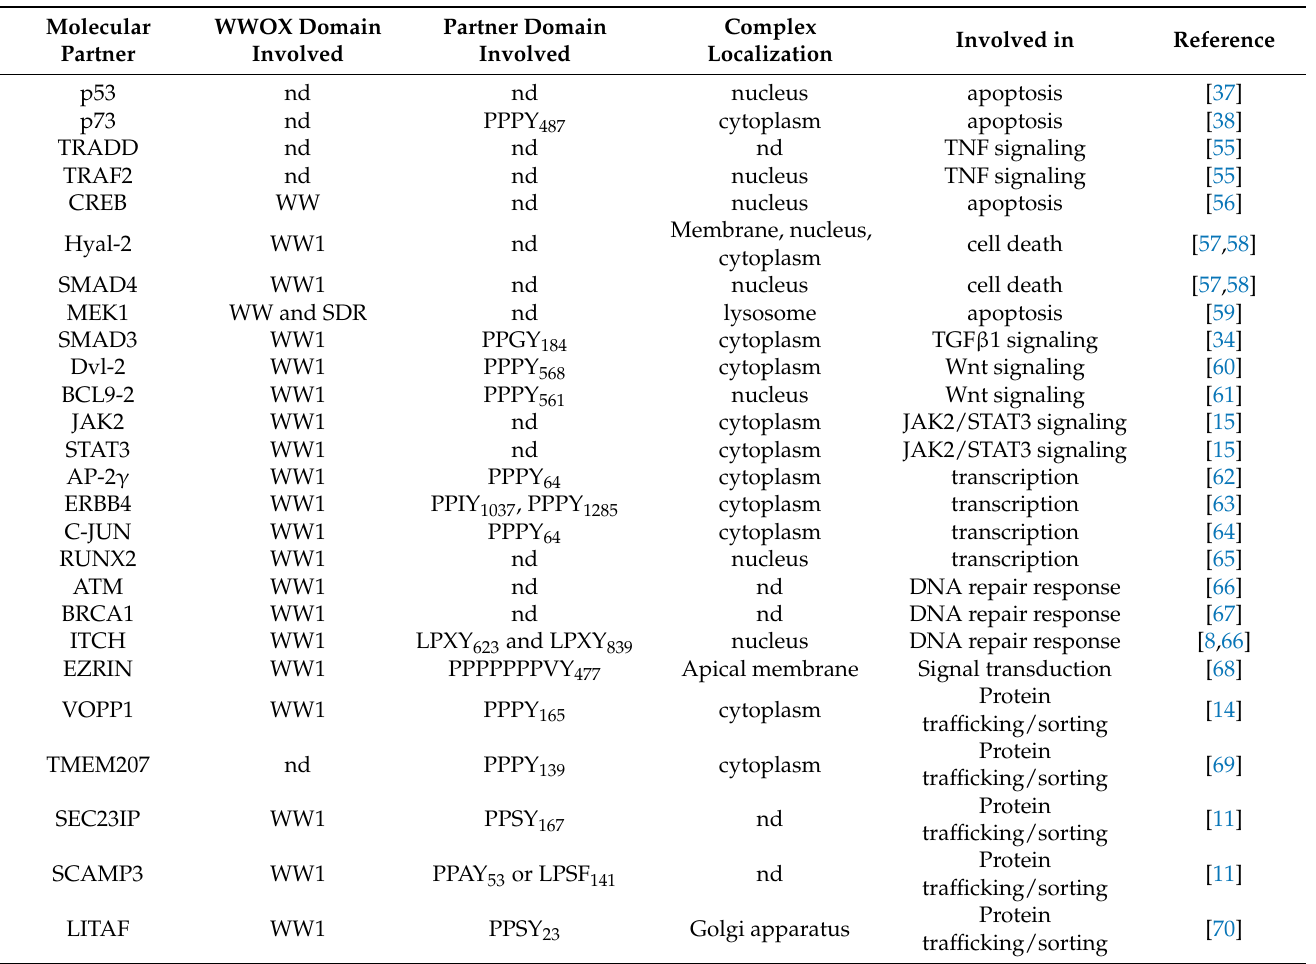
Table 1. Main protein partners involved in the anticarcinogenic molecular functions of WWOX (nd: not defined, P: proline, Y: tyrosine, S: serine, L: leucine, A: alanine, X: any amino acid).